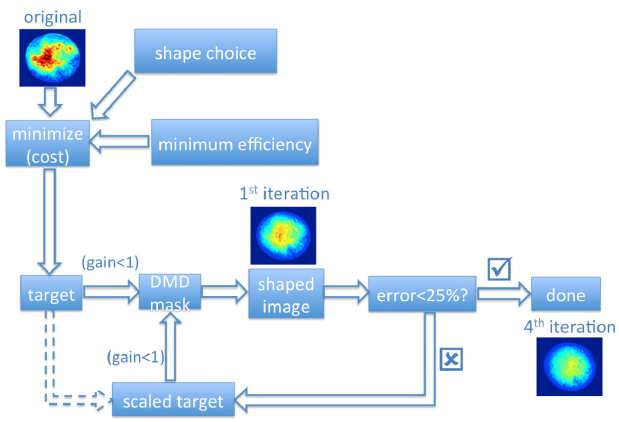
FIG. 3. Flow chart of the shaping algorithm, with example VCC images of the laser beam in the original shape, after the first iteration, and after the fourth iteration.